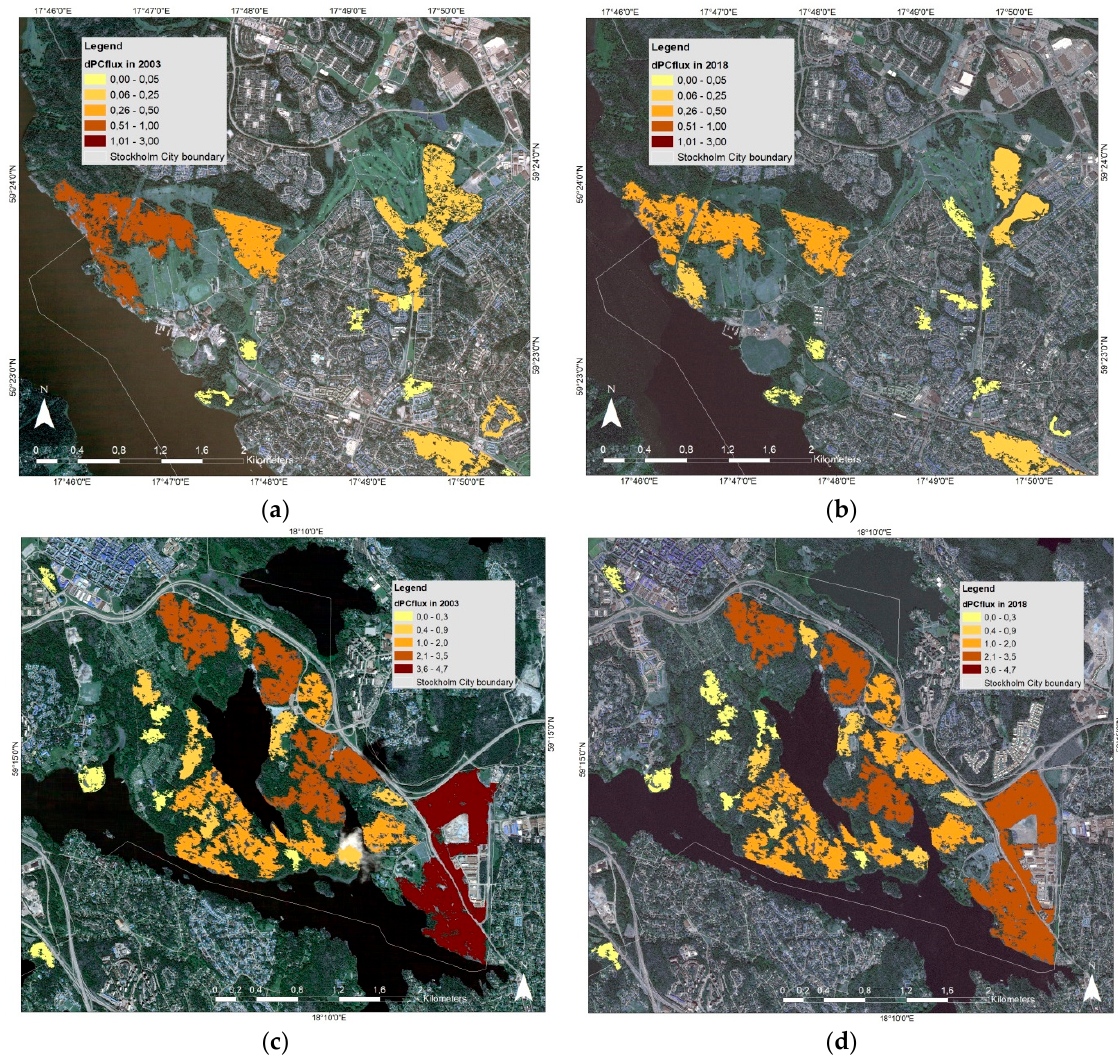
Figure 11. dPCflux values per habitat patch in ( a ) west Hässelby-Vällingby 2003, in ( b ) west Hässelby-Vällingby 2018, in ( c ) southern Skarpnäck 2003 and in ( d ) southern Skarpnäck 2018